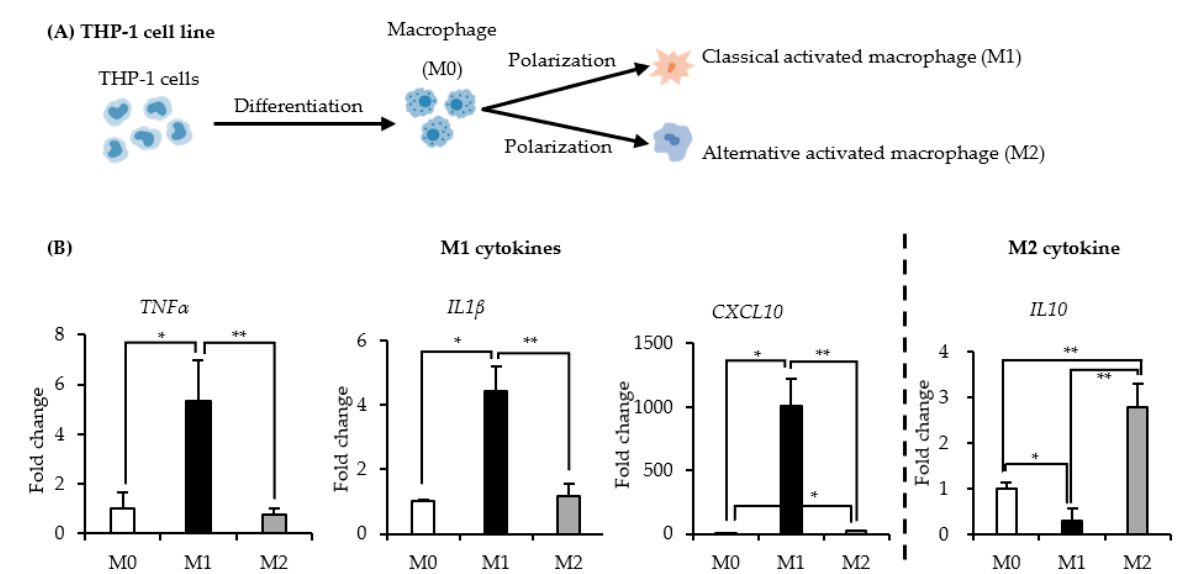
Figure 1. Human monocyte THP-1 cell differentiation and polarization. ( A ) Human monocyte THP-1 cell differentiation and polarization model diagram. THP-1 cells were firstly differentiated to M0 macrophages, and then induced to M1 or M2 macrophages. ( B ) The expression of M1 ( TNF α , IL1 β , and CXCL10 ) and M2 ( IL10 ) macrophage related cytokines by qPCR. ( n = 3). ** p < 0.01, * p < 0.05.